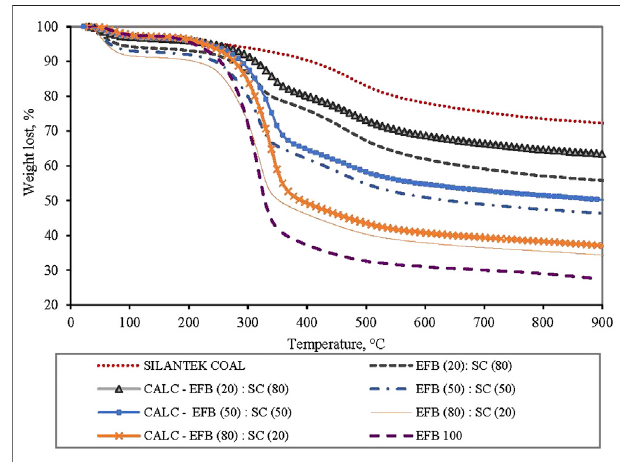
FIGURE 6 | Experimental and calculated data of EFB and SC heating rate of 10 ° C/min.